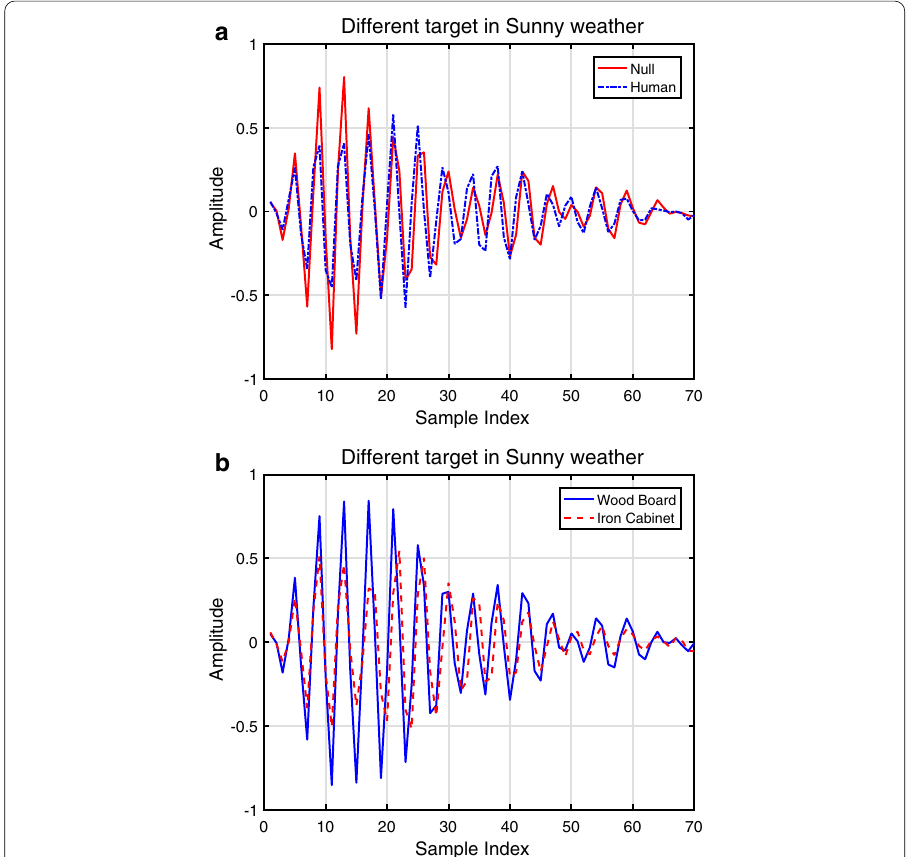
Fig. 4 Received UWB signals of different target in sunny